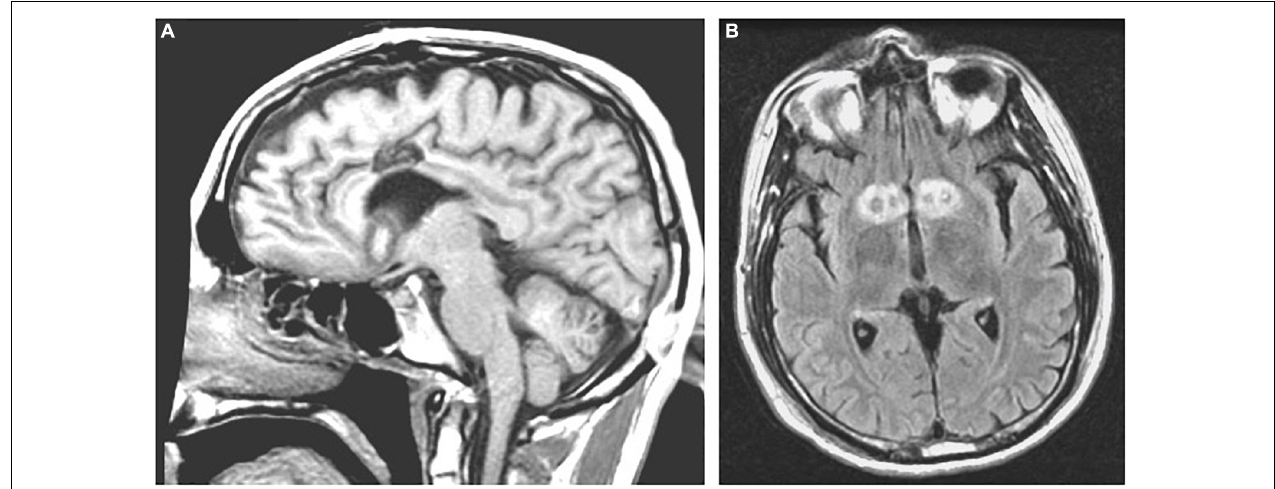
FIGURE 7 | Limbic leucotomy. (A) Sagittal T1-weighted and (B) Axial FLAIR MRI of limbic leucotomy